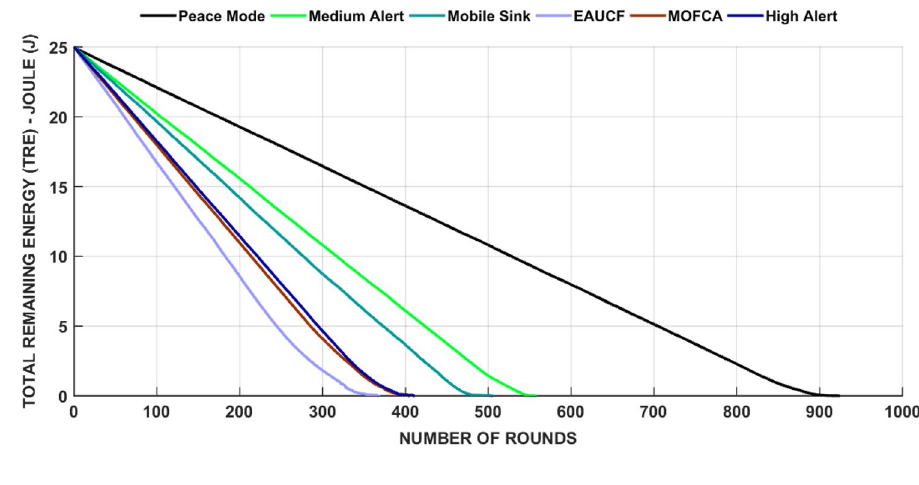
Fig. 12 Total remaining energy in relation to the number of rounds in scenario 2, the sec- ond protocol